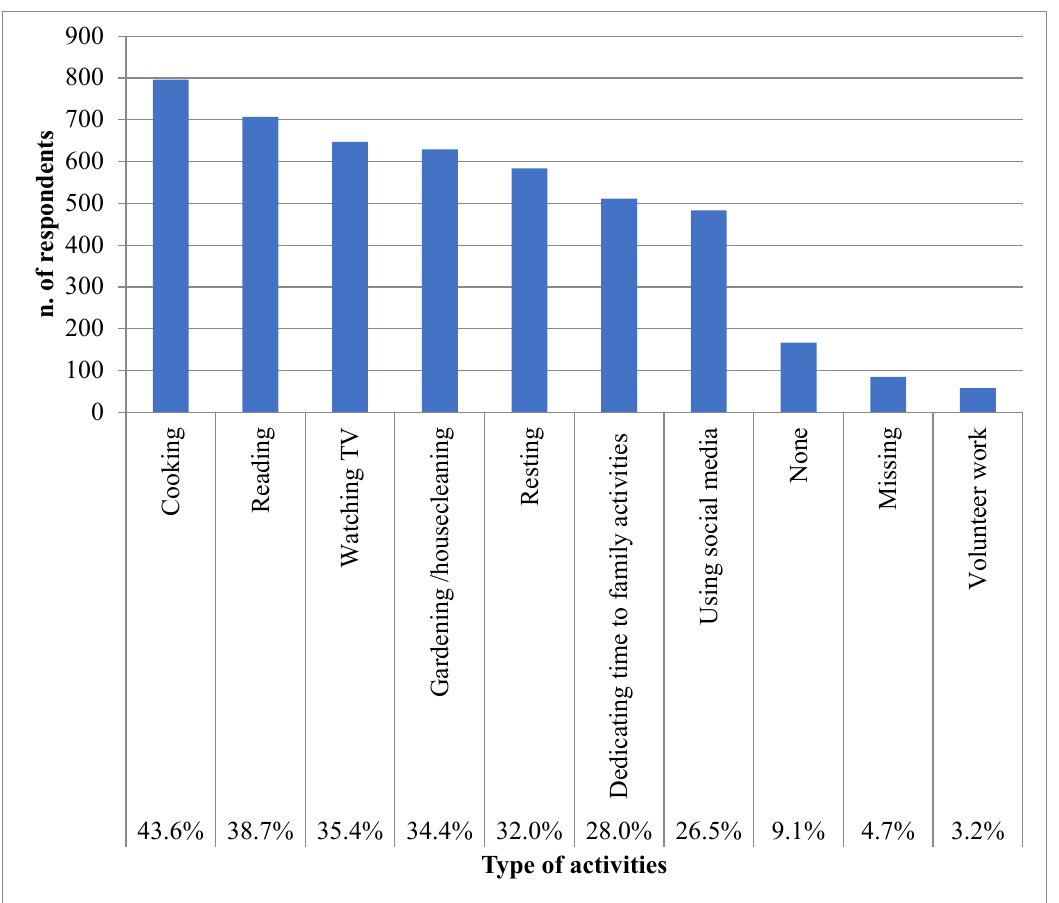
Figure 1. Percentages of participants who carried out new activities, described also as types, during the first lockdown.